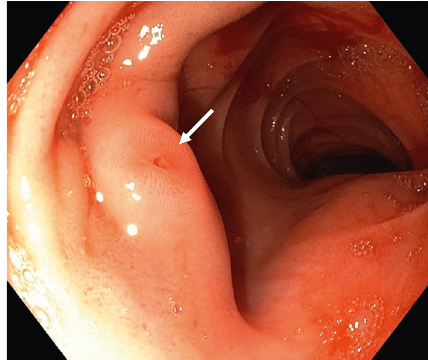
Figure 4: Enteroscopy showing the nipple sign at the site of the